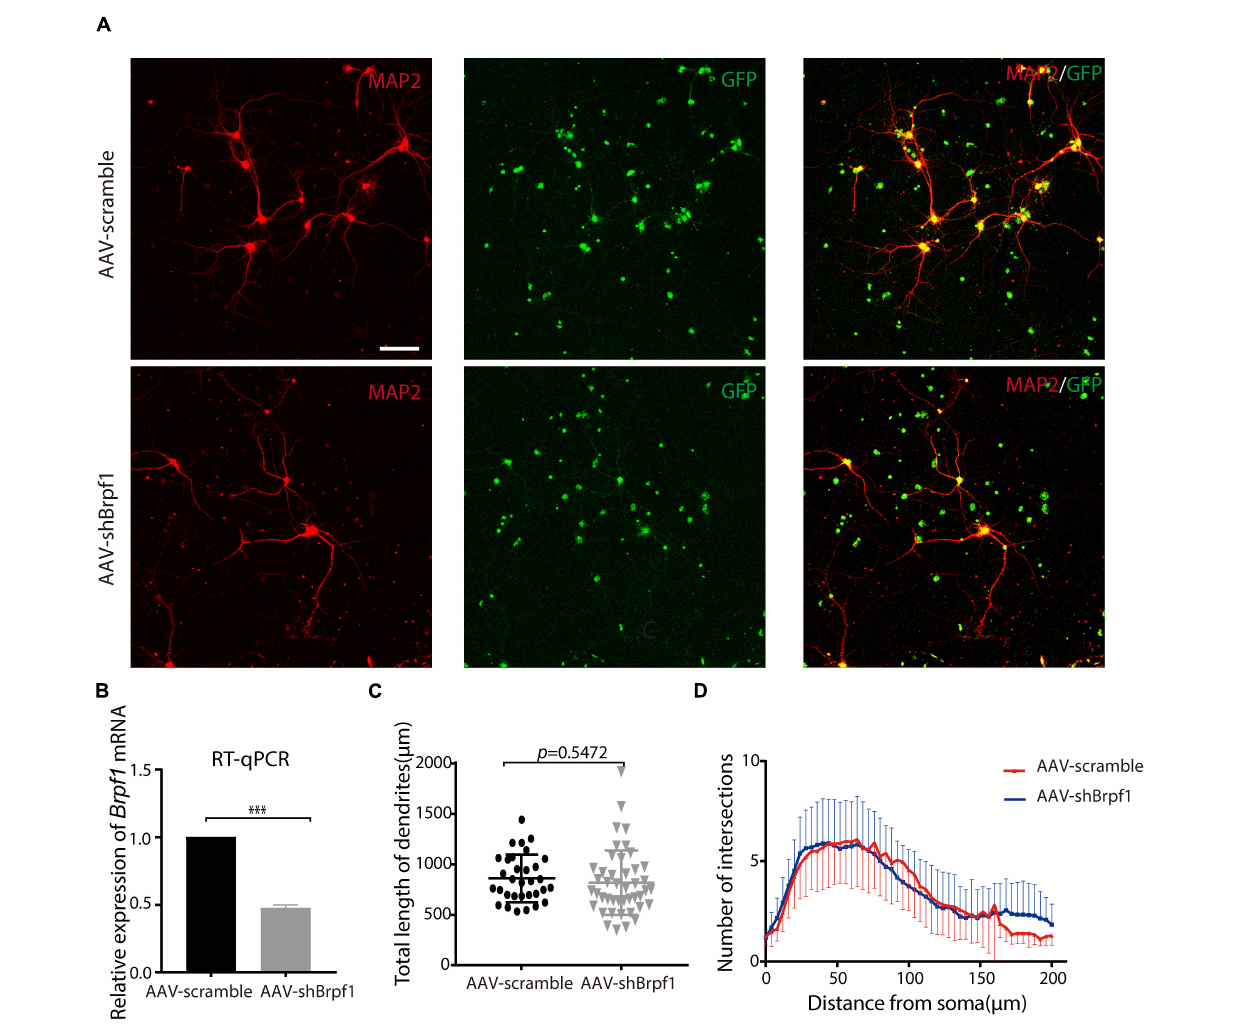
FIGURE 1 | Mild knockdown of Brpf1 did not significantly change the total dendritic length and number of intersections. (A) Representative fluorescent images of cultured primary hippocampal neurons at DIV15 immunostained with anti-Map2 antibody, scale bar = 75 µ m. (B) Quantitative mRNA analysis of Brpf1 knockdown efficiency ( n = 4 batches for AAV-scramble and AAV-shBrpf1 groups, respectively, p < 0.001). (C) Quantification of total dendritic length of AAV-scramble or AAV-shBrpf1 group using “Simple Neurite Tracer” of ImageJ ( n = 32 or 44 neurons from three independent batches for AAV-scramble or AAV-shBrpf1 group, respectively, p = 0.5472). (D) Sholl analysis of the number of intersections of the dendrites ( n = 32 or 44 neurons from three independent batches for AAV-scramble or AAV-shBrpf1 group, respectively). *** p <